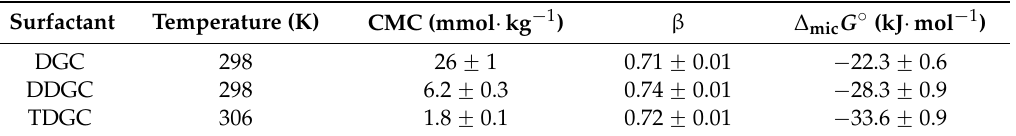
Table 2. Critical micelle concentration, CMC, and degree of counter-ion binding to the micelle, β , for guanidinium cationic